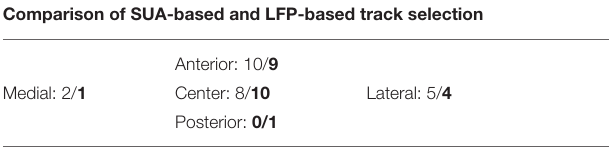
TABLE 3 | Frequency of track selection in the present study. Comparison of SUA-based and LFP-based track